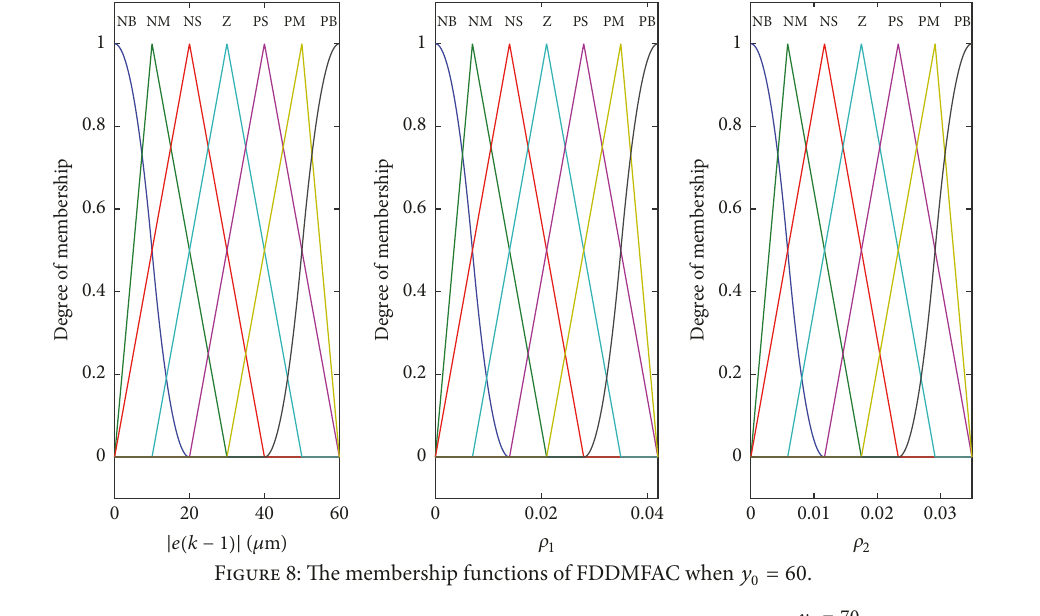
Figure 8: The membership functions of FDDMFAC when 𝑦 0 = 60 .